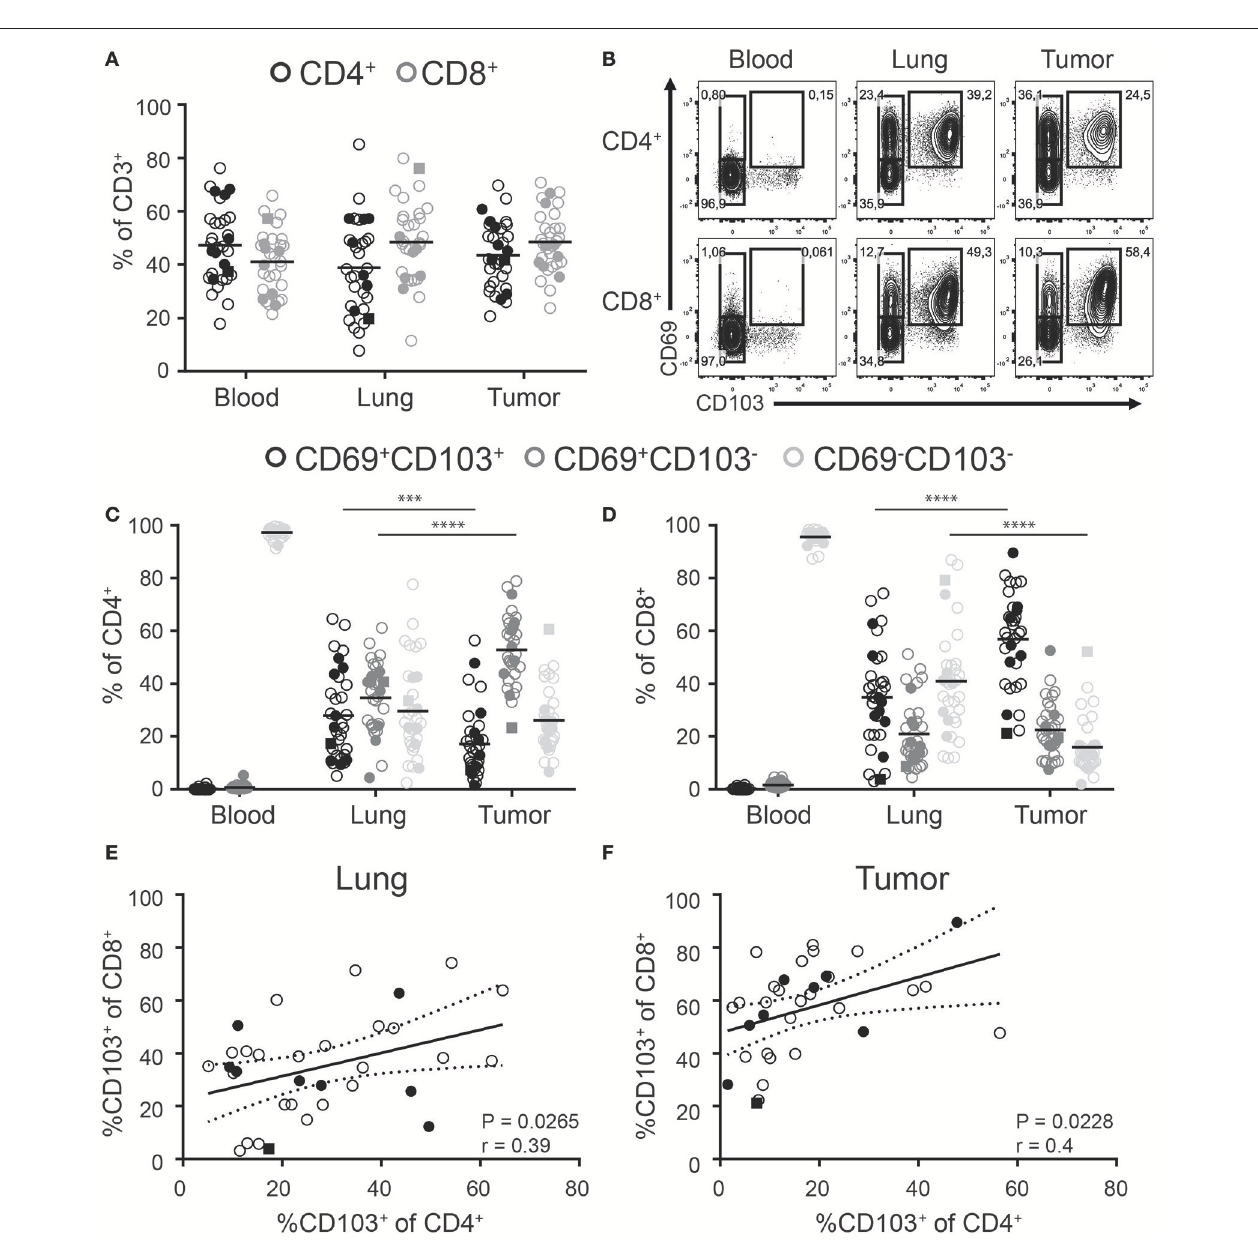
FIGURE 1 | Distribution of CD103 and CD69 expression on CD4 + and CD8 + T cells of paired blood, lung, and tumor samples. (A) Frequencies of CD4 + (black circles) and CD8 + (gray circles) cells of total CD3 + T cells of paired blood, lung, and tumor tissue was analyzed by flow cytometry. (B–D) The expression of CD69 and CD103 was analyzed on paired blood, lung and, tumor CD4 + and CD8 + T cells. (B) Contour plots show representative examples of CD69 and CD103 expression on blood (left panels), lung (middle panels), and tumor (right panels) CD4 + (top panels) and CD8 + (bottom panels) T cells. (C,D) Frequencies of CD103 + CD69 + (black circles), CD103 − CD69 + (dark gray circles), and CD103 − CD69 − (light gray circles) cells of total blood, lung, and tumor CD4 + (C) and CD8 + (D) T cells were quantified. (E,F) Correlation between CD103 + CD8 + and CD103 + CD4 + lung (E) and tumor (F) T cells was determined. (A–F) n = 33. Open circles, solid circles, solid square indicate adeno-, squamous, and large cell carcinoma, respectively. (A,C,D) Quantifications are shown as dot plots with the horizontal line indicating the mean and each point represents a unique sample. (E,F) Correlation shown as X-Y graph where each point represents a unique sample. (C,D) *** p < 0.001, **** p < 0.0001; 2-way analysis of variance (ANOVA) with Tukey’s multiple comparisons test. (E,F) r, Pearson’s rank coefficient; p < 0.05.